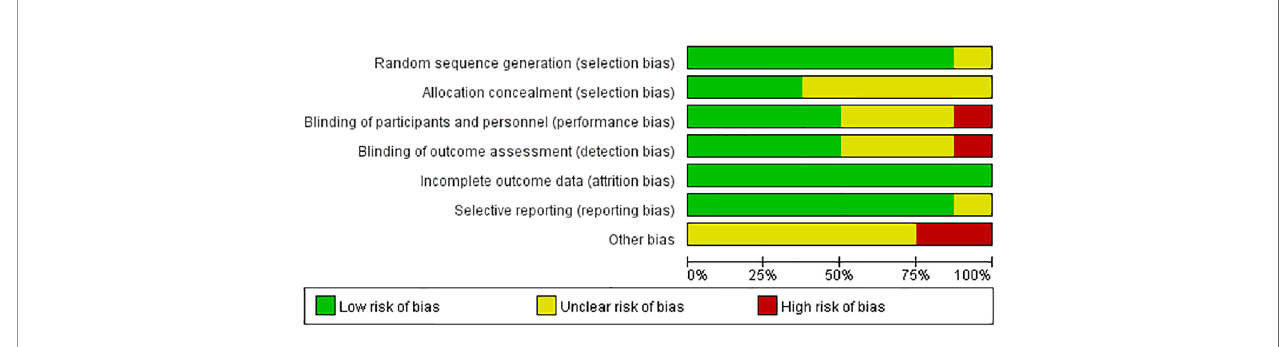
FIGURE 2 | Risk of bias graph: Authors ’ judgements about each risk of bias item are presented as percentages across all